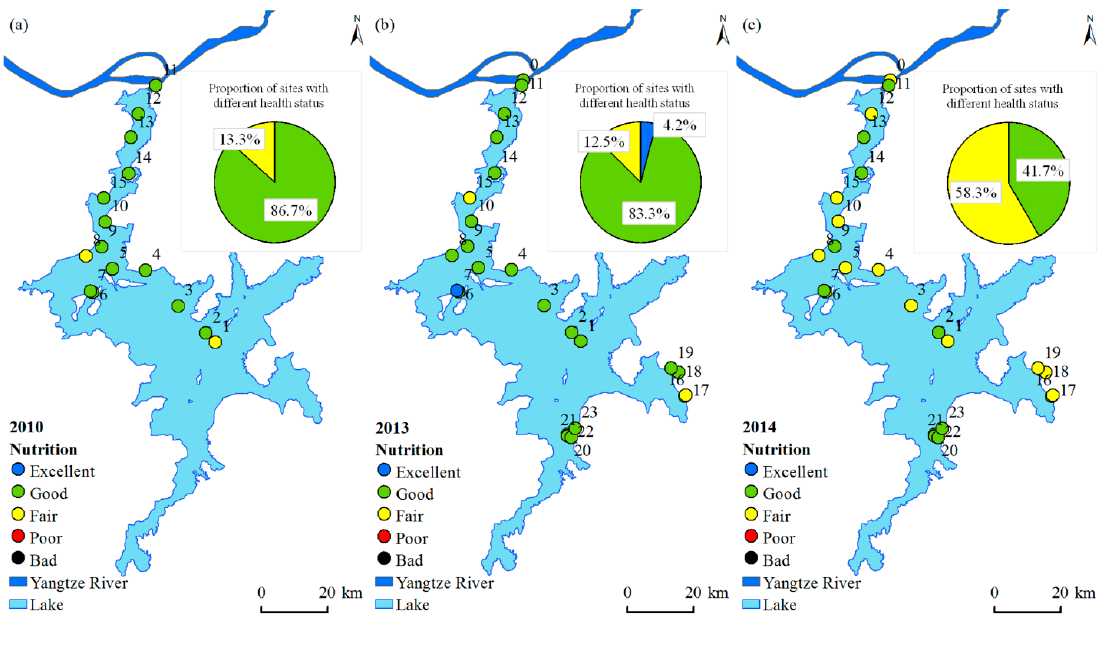
Figure 6. Health status of nutrient conditions at the sample sites in Lake Poyang in 2010 ( a ), 2013 ( b ) and 2014 ( c ).